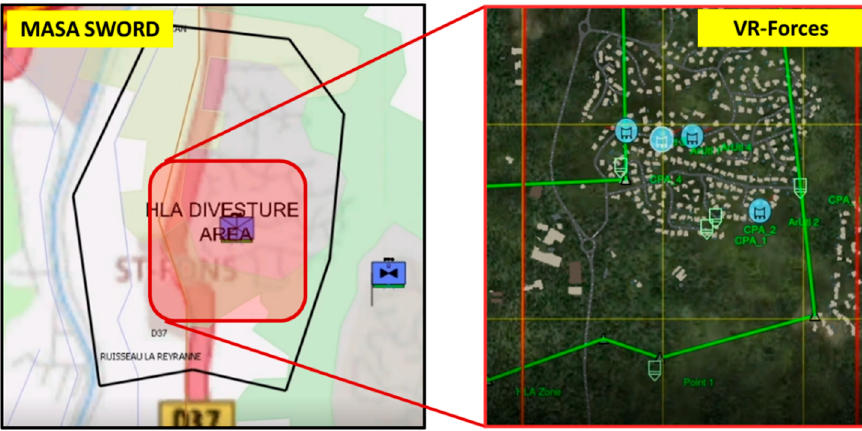
Figure 19. Disaggregation and aggregation implementation.